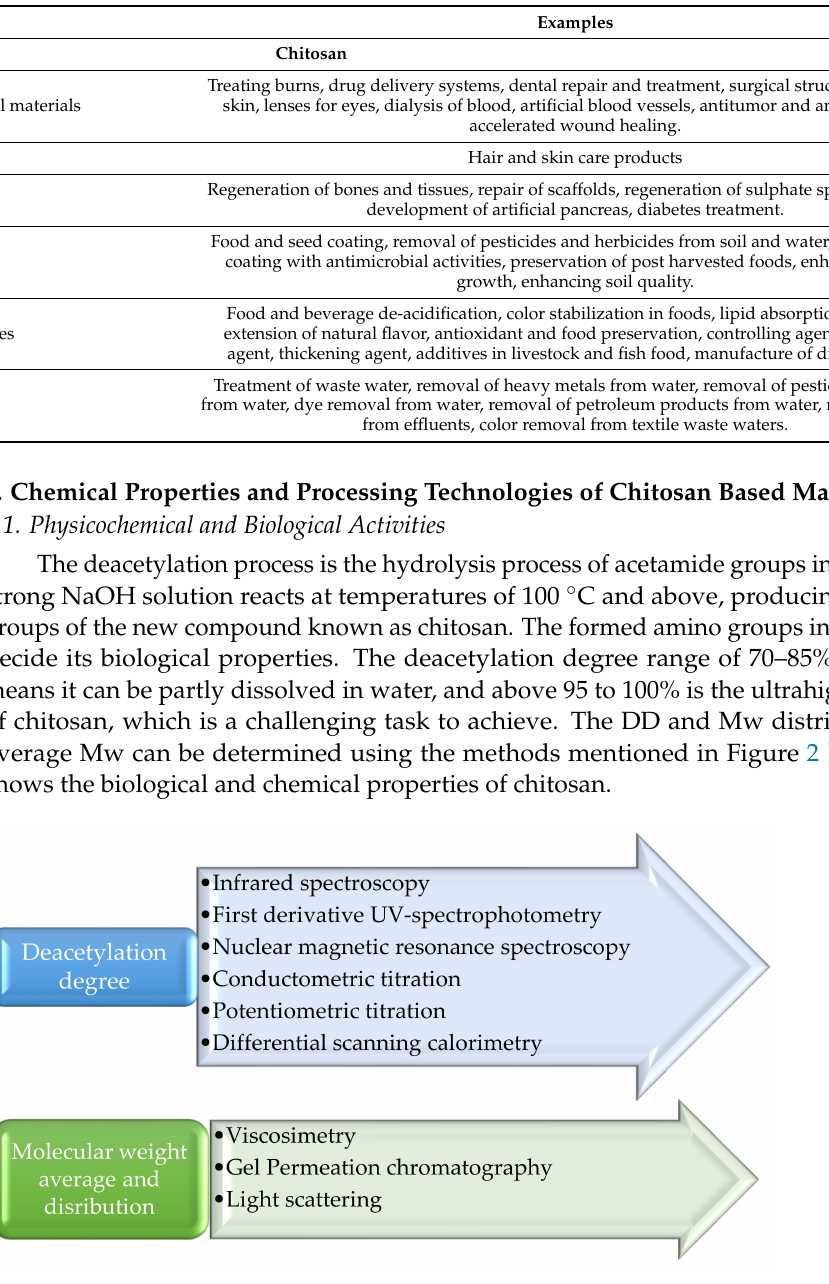
Figure 2. Determination methods followed for Deacetylation degree and Molecular weight distribu- tion and average. Table 2. Chemical and biological properties of chitosan